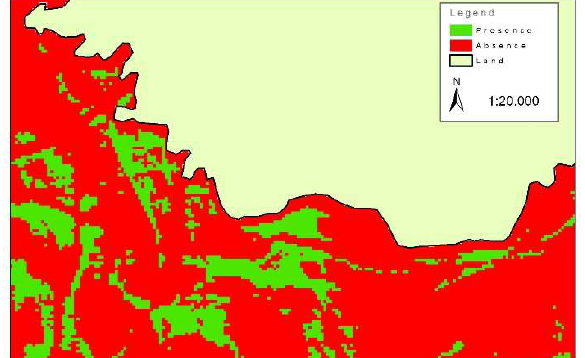
Figure 5. Final seagrass cover map (Green = Presence, Red = Absence) A total area of 13.75 kilometre square has been classified. Seagrass seems to be present at the %18.3 of study area. Rest of the area mostly consists of